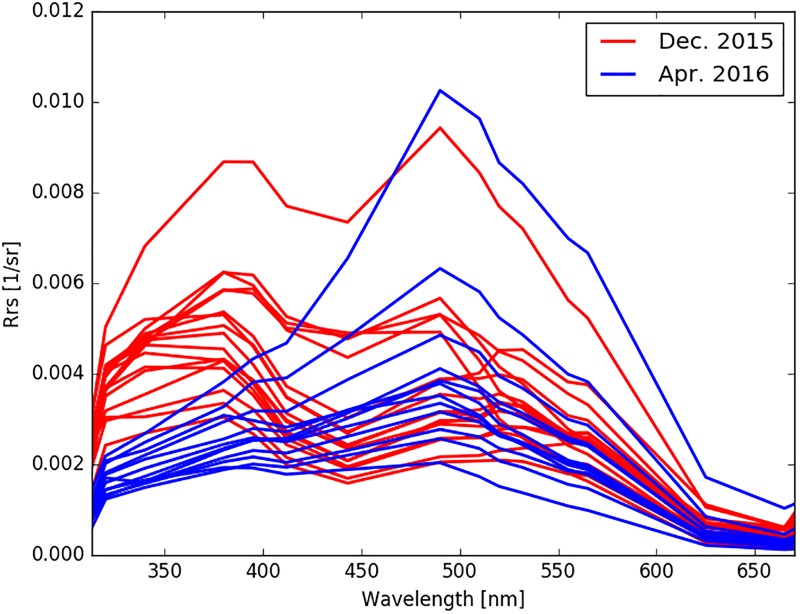
Remote sensing reflectance at the surface demonstrates a shift in spectral shape between December 2015 and April 2016.